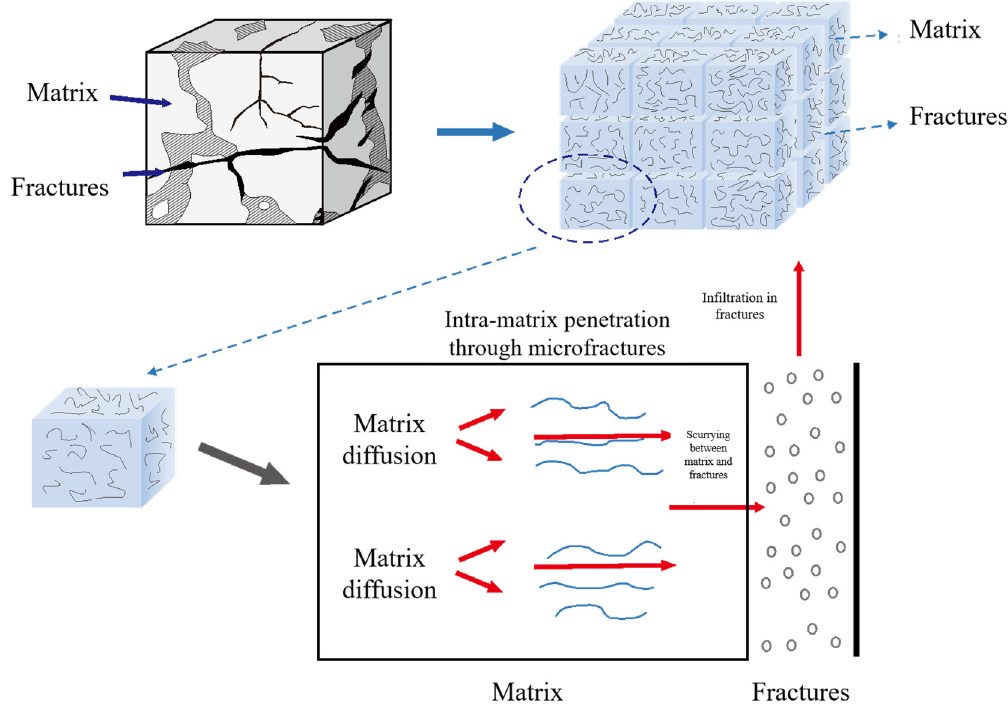
Figure 5. Warren–Root Model with Double Porosity and Double Permeability.